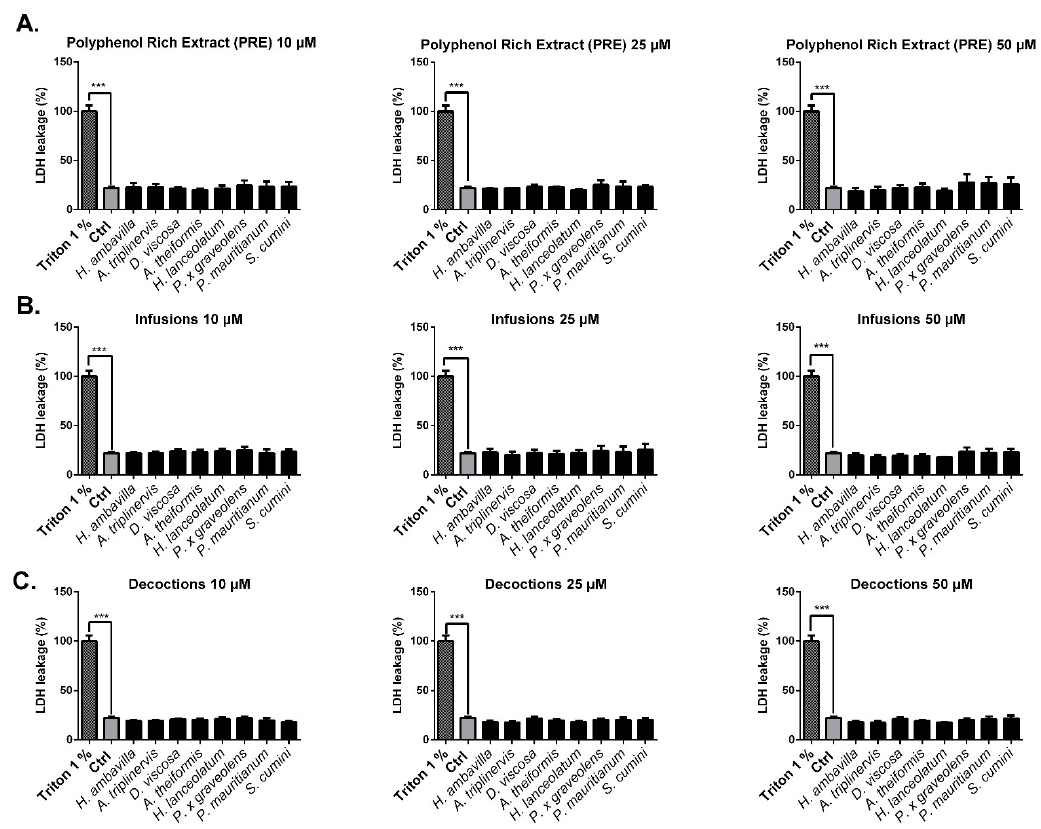
Figure 5. Impact of medicinal plant preparations on 3T3-L1 preadipocytes necrosis. 3T3-L1 preadipocytes were incubated for 24h with polyphenol-rich extracts (PRE) ( A ), infusions ( B ) and decoctions ( C ). LDH release (%) was measured in the supernatant. Triton X100 (1%) was used to induce cell necrosis (considered as 100% necrosis). Absorbance was read at 450 nm. The data shown are means ± SEM of three independent experiments *** p < 0.005 as compared to control. LDH: lactate dehydrogenase (an intracellular enzyme whose release into the extracellular medium reflects cell necrosis).